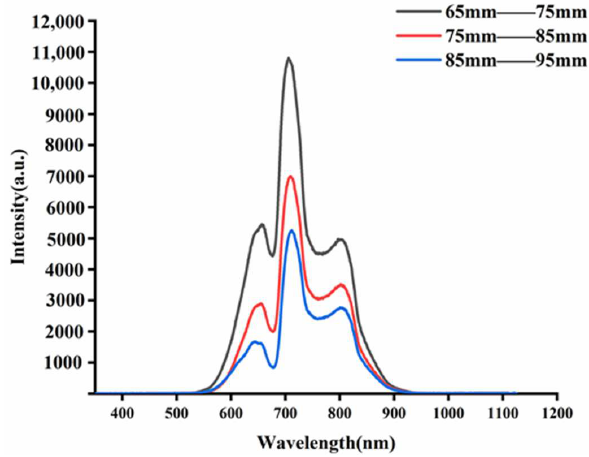
Figure 2. Raw spectra of three sets of fruit diameter